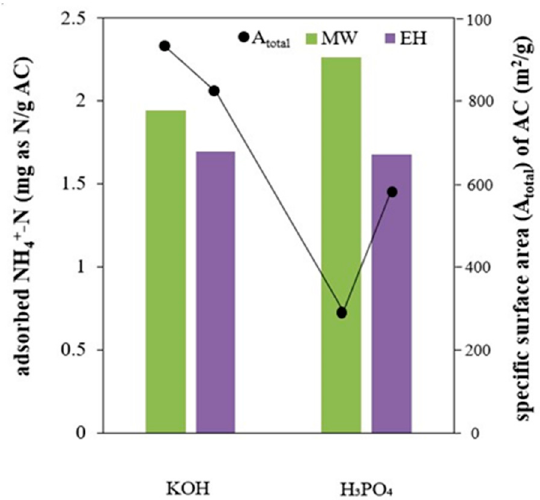
Figure 4. Ammonium (NH 4+ ) adsorption onto activated carbon (AC) at pH 6.0 ± 0.05 for 24 h. The left Y -axis indicates ammonium adsorption in milligrams of N per gram of AC, and the right Y -axis is the specific surface area of AC. EH: electric heating; MW: microwave radiation.